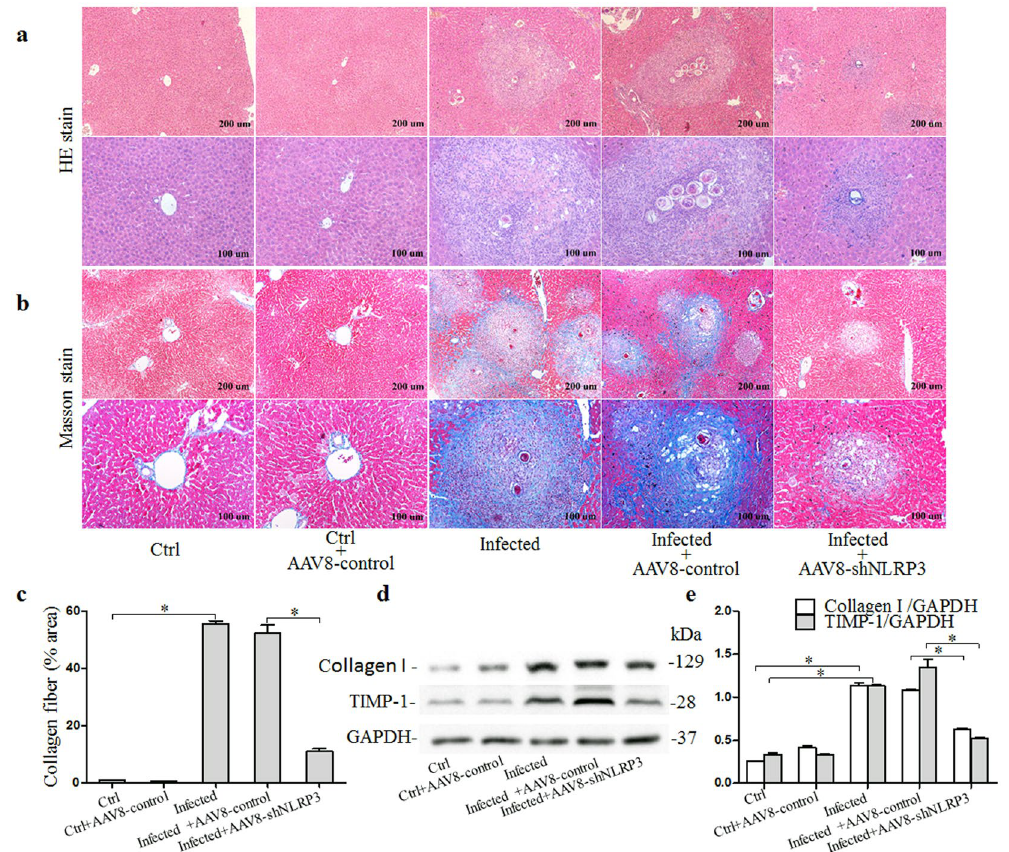
Figure 2. Pathological changes in liver tissues from mice 6 weeks after infection with S. Japonicum : ( a ) Representative images of HE stained liver tissue; ( b ) Representative images of masson stained liver tissue and ( c ) quantitative analysis of positive stain of collagen fiber; ( d ) western blot gels and ( e ) summarized data showing the expression of collagen-1 and TIMP-1, full-length blots are included in the Supplementary Fig. S2. Ctrl: control (n = 4); Ctrl + AAV8-control: control mice injected with AAV8-control (n = 4); Infected: mice infected with S. Japonicum (n = 6); Infected + AAV8-control: Infected mice injected with AAV8-control (5 × 10 9 vg per animal) (n = 6); Infected + AAV8-shNLRP3: Infected mice injected with AAV8-shNLRP3 (5 × 10 9 vg per animal) (n = 6). Results are a representative of at least three independent experiments. * p <